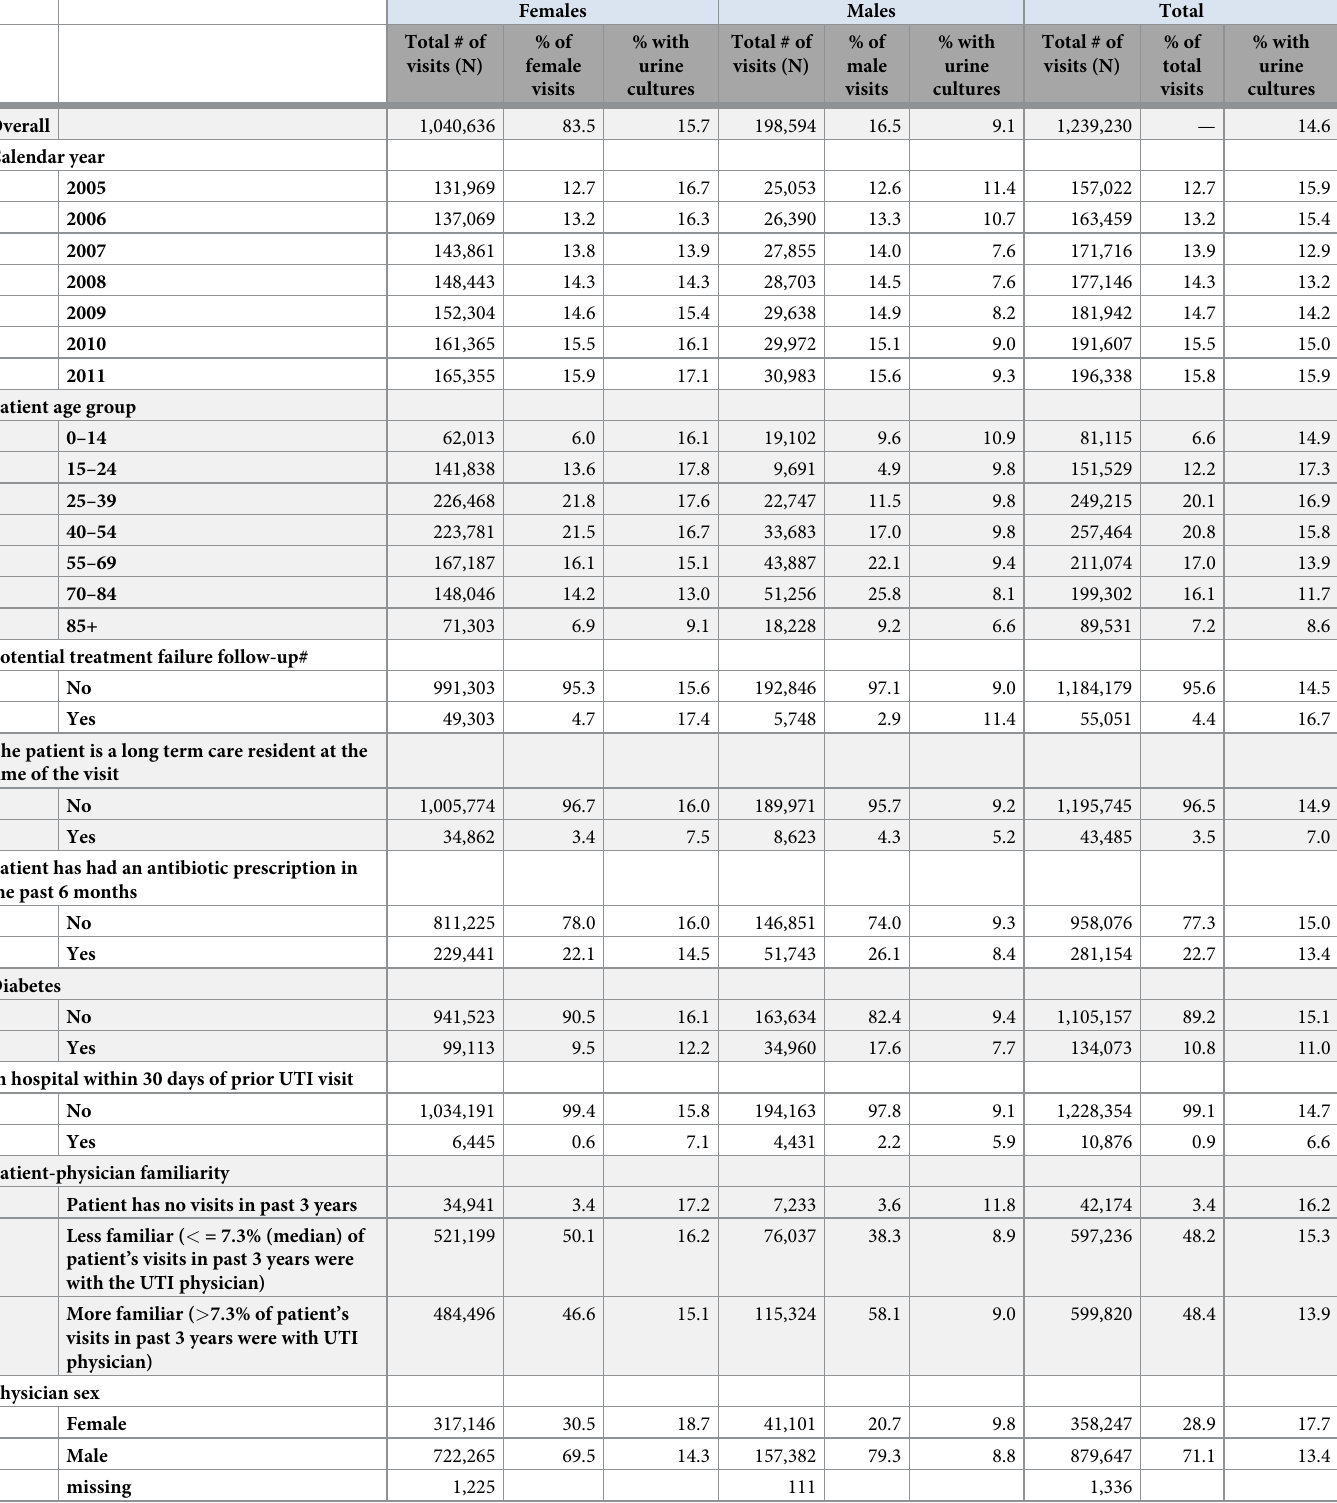
Table 1. Distribution of visits and urine cultures.